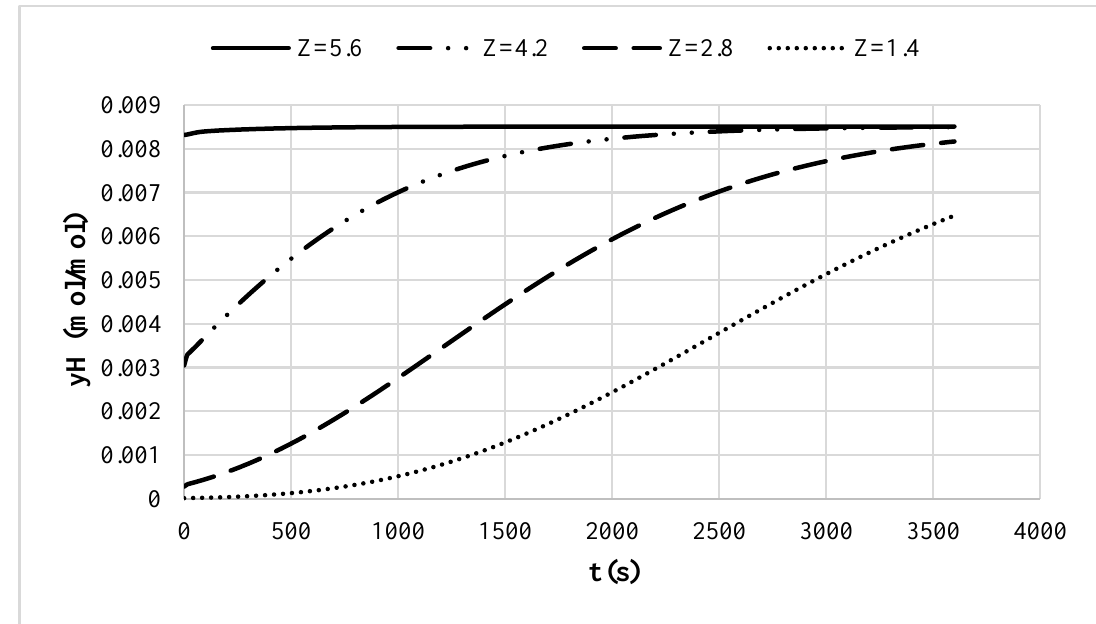
Figure 16. Hexane output mole fraction in four different zones of the bed.